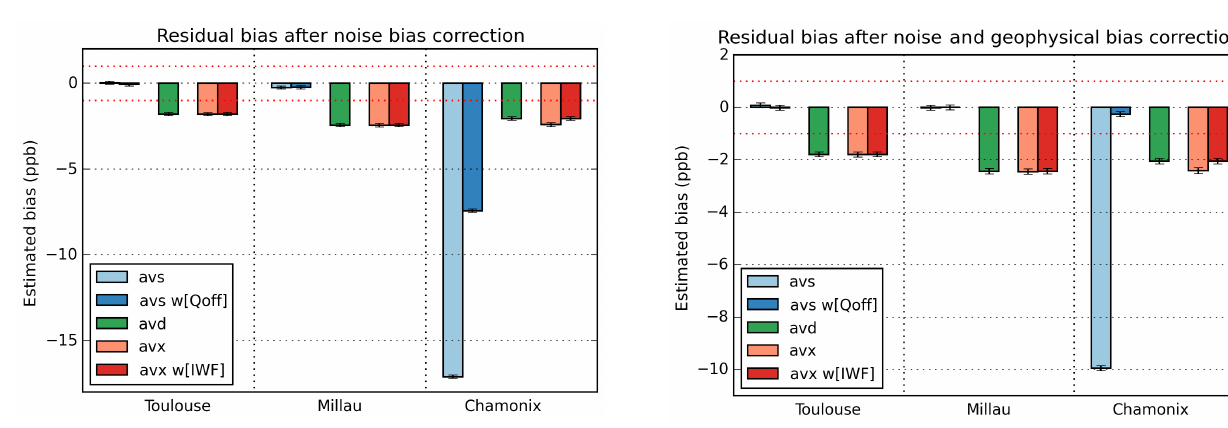
Figure 12. Residual bias after noise induced bias and geophysical variation induced bias corrections for the three studied averaging schemes (red dotted lines: targeted bias ±